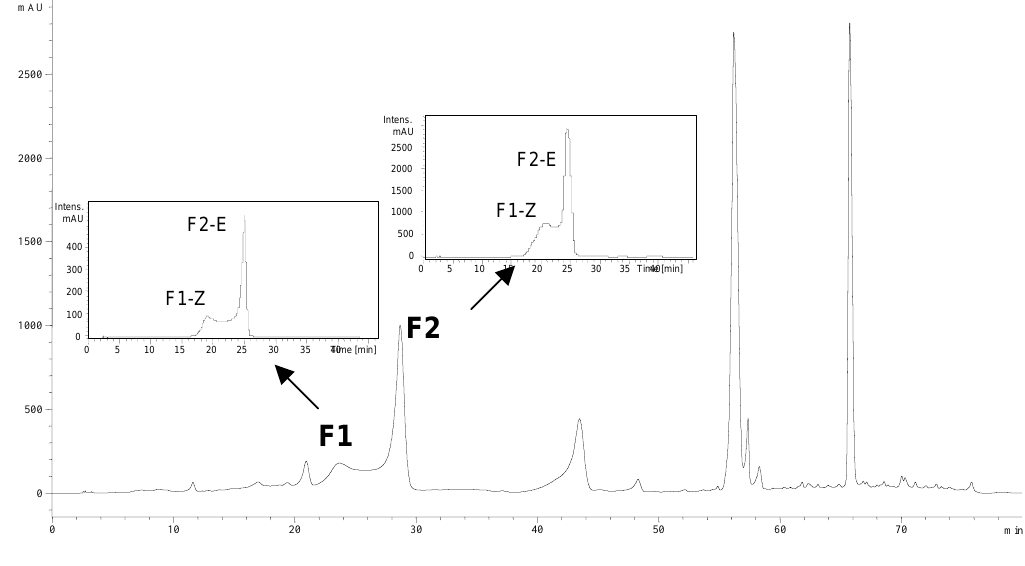
Figure 1. Analytical HPLC chromatogram of Populus tremula knotwood extract recorded at 314 nm. Inserts represent the chromatograms of the fractions F1 and F2 isolated using preparative HPLC.